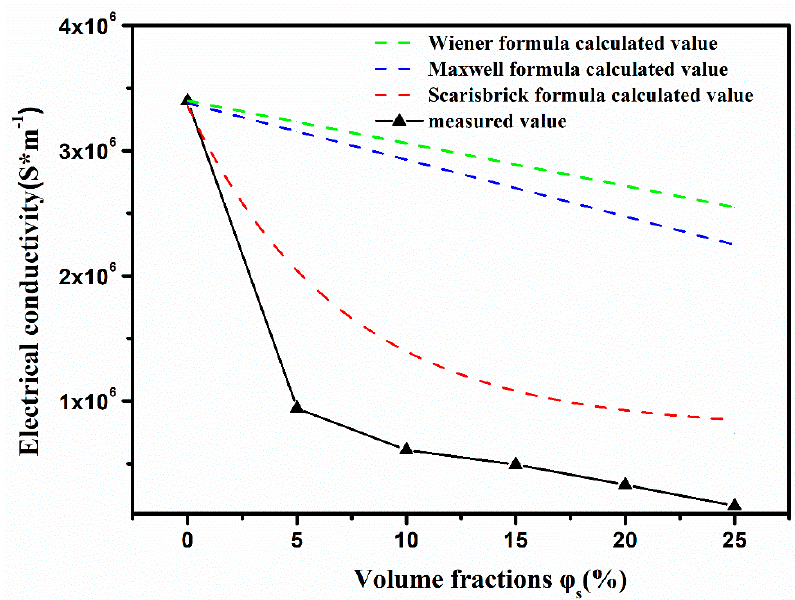
Figure 5. Variation of the conductivity of flowable tritium breeder composite with different volume fraction ϕ s .